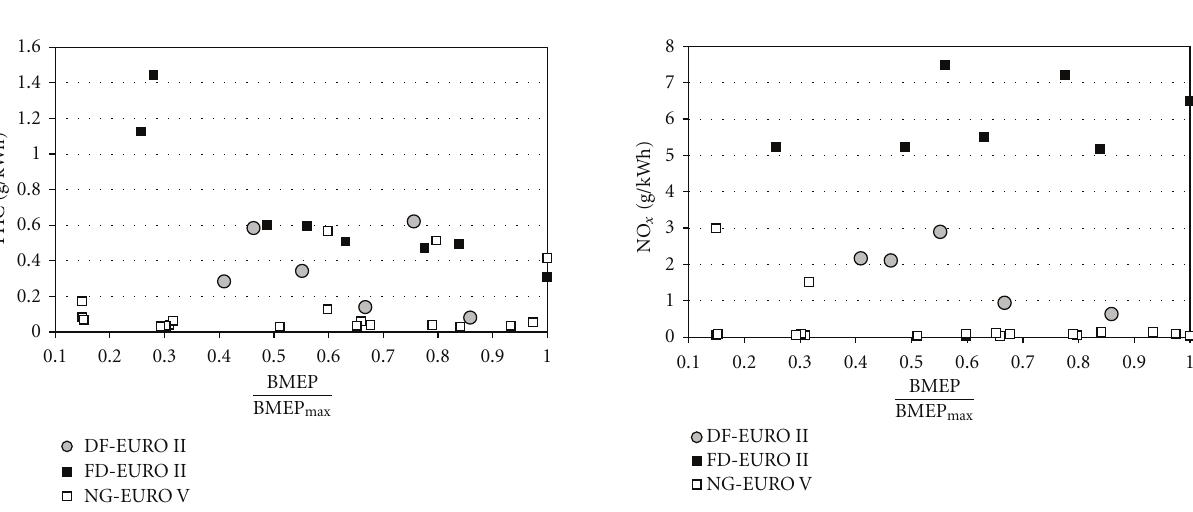
Figure 6: CO emission for DF, FD and full NG engines measured in the condition of Figure 4.